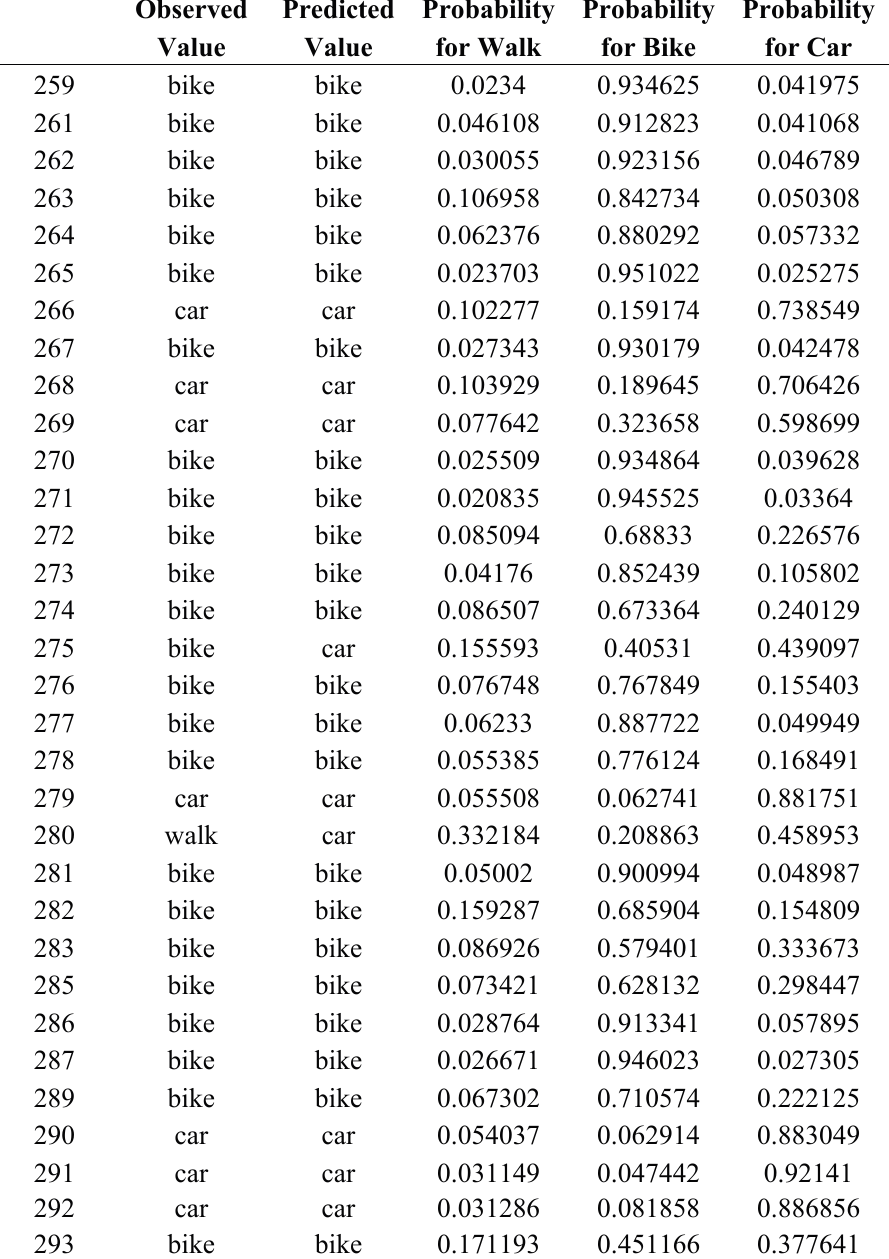
Table 5. Boosting tree